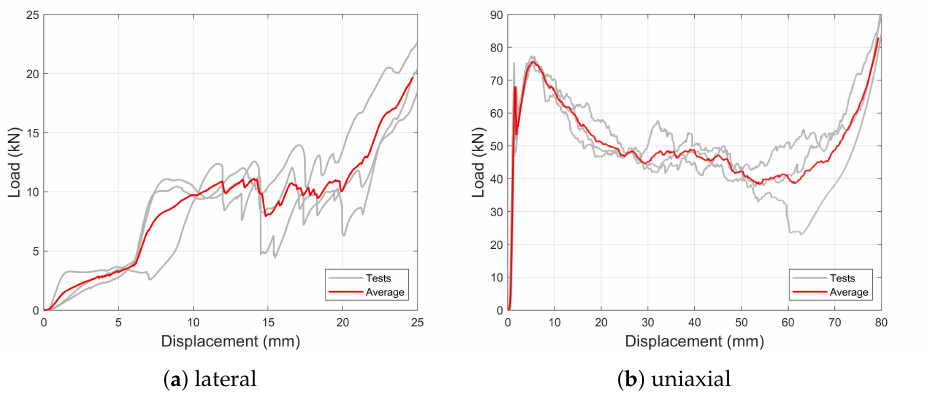
Figure 10. Load–displacement curves related to the lateral and uniaxial crush of chiral-filled tubes. Table 7. Properties of the chiral-filled tubes under lateral and uniaxial